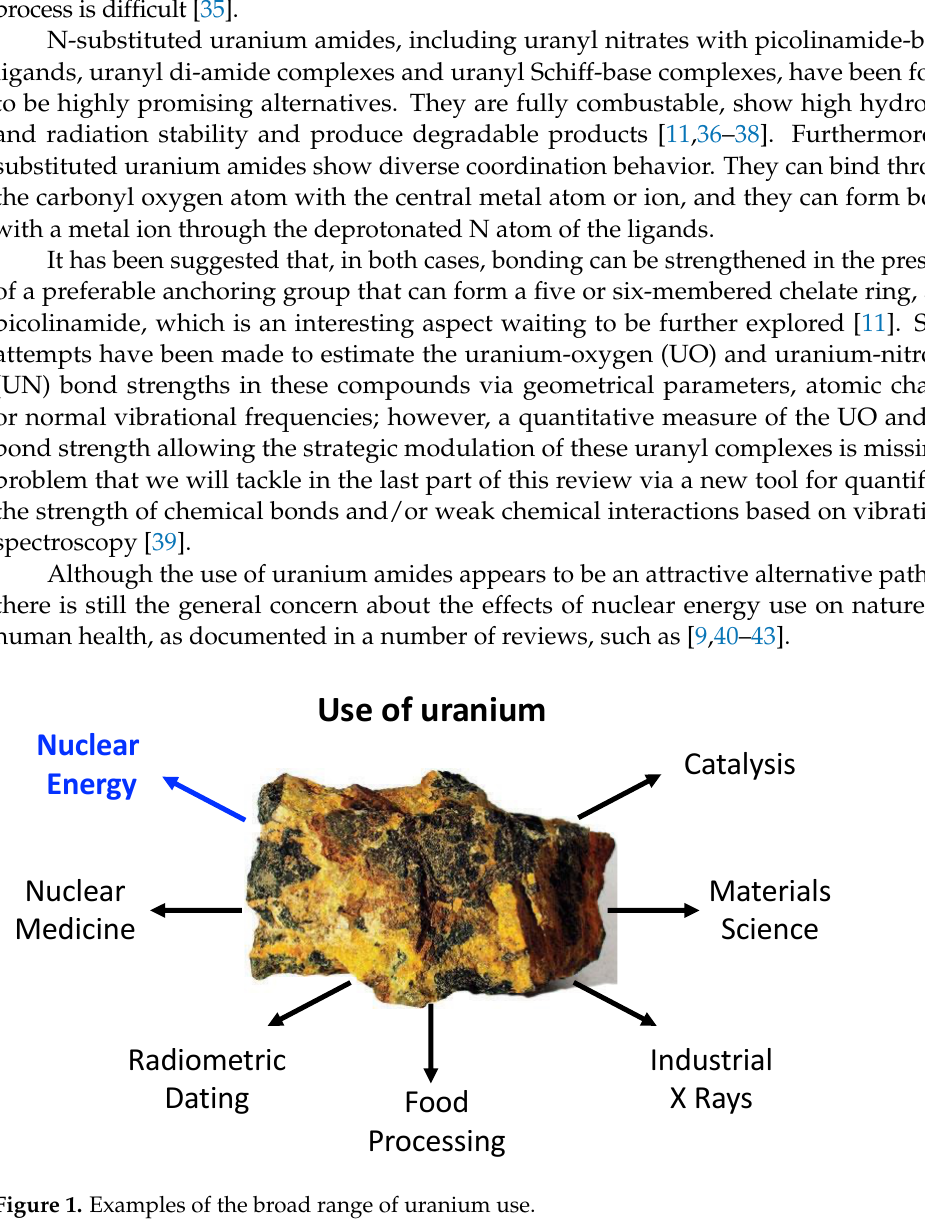
Figure 1. Examples of the broad range of uranium